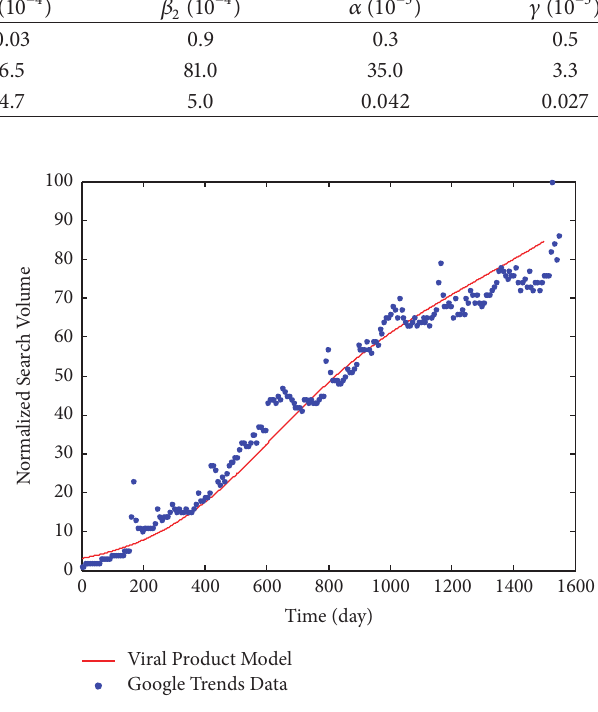
Figure 2: Model fitting on “Instagram” from October 2011 to January 2016.